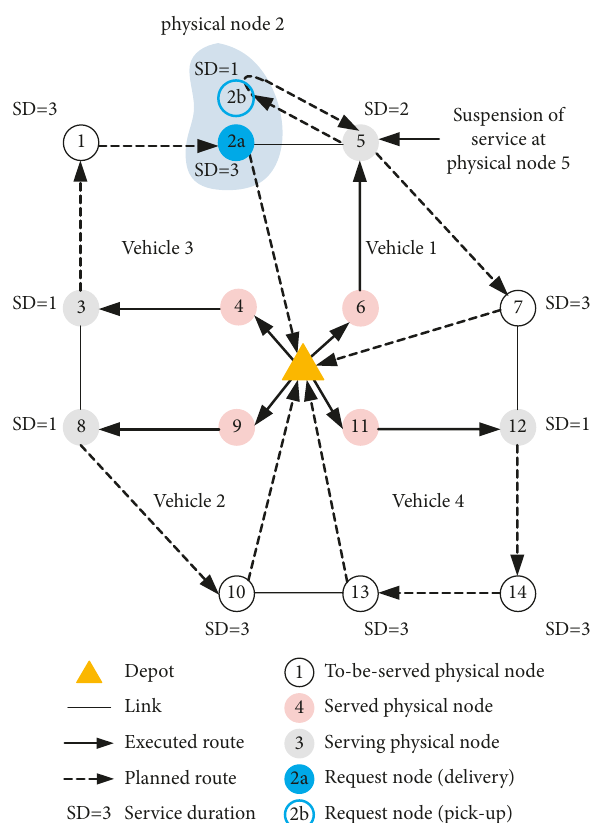
Figure 11: Optimal solution for each vehicle when handling pick- up request at τ � 9.